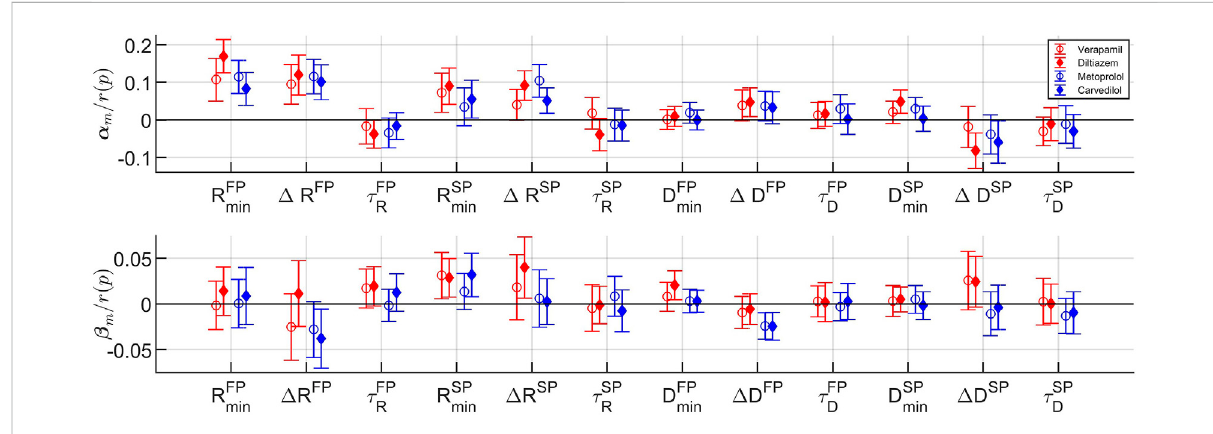
FIGURE 7 The fi xed effects with corresponding 95% con fi dence intervals for the cosinor mean m (top) and cosinor amplitude a (bottom) for each model parameter (cf. Table 1) and drug. Con fi dence intervals not overlapping zero indicate signi fi cant difference from baseline ( p <